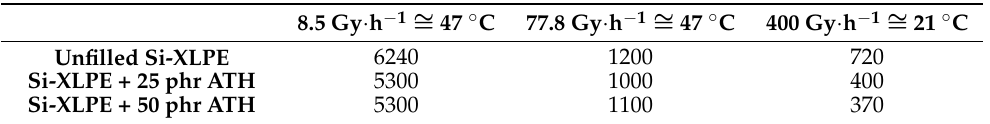
Table 5. Lifetime values (expressed in hours) graphically determined for the three materials under the three exposure conditions under study, as shown in Figure